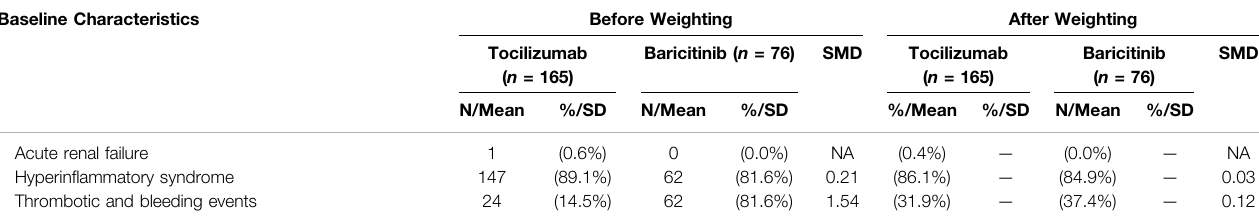
TABLE 1 | ( Continued ) Baseline characteristics of hospitalized patients with COVID-19 in tocilizumab and baricitinib groups after multiple imputation and propensity score weighting. Baseline Characteristics